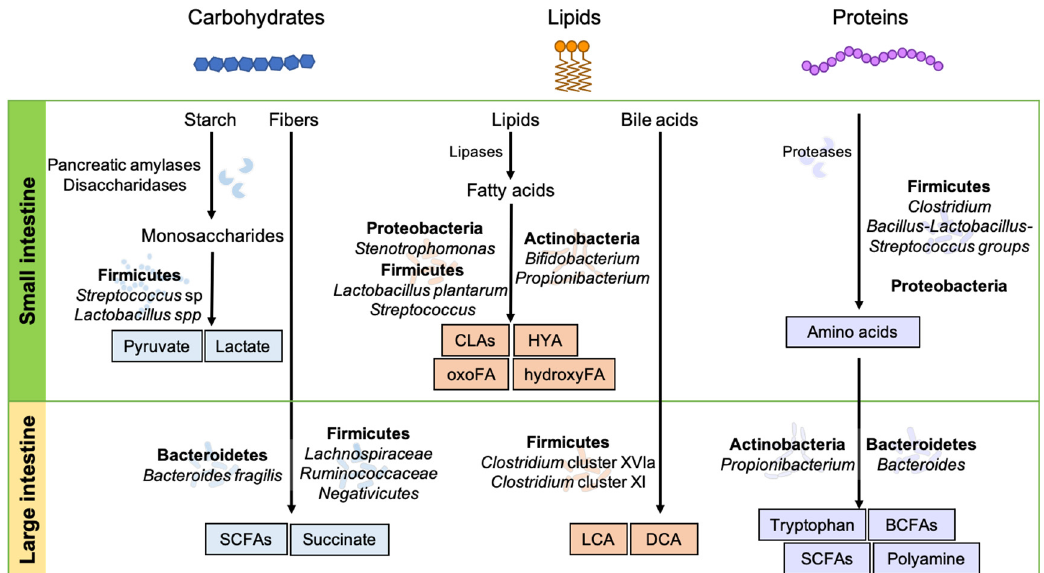
Figure 1. Dietary metabolism in the gastrointestinal tract. Dietary components—carbohydrates, lipids, and proteins—are digested into diverse metabolites via complex reactions of enzymes released from host tissues and microbial fermentation in the gut. BCFAs, branched chain fatty acids; CLAs, conjugated linoleic acids; DCA, deoxycholic acid; HYA, 10-hydroxy- cis-12-octadeccenoid acid; hydroxy FA, hydroxy fatty acid; LCA, lithocholic acid; oxoFA, oxo fatty acid; SCFAs, short chain fatty acids.